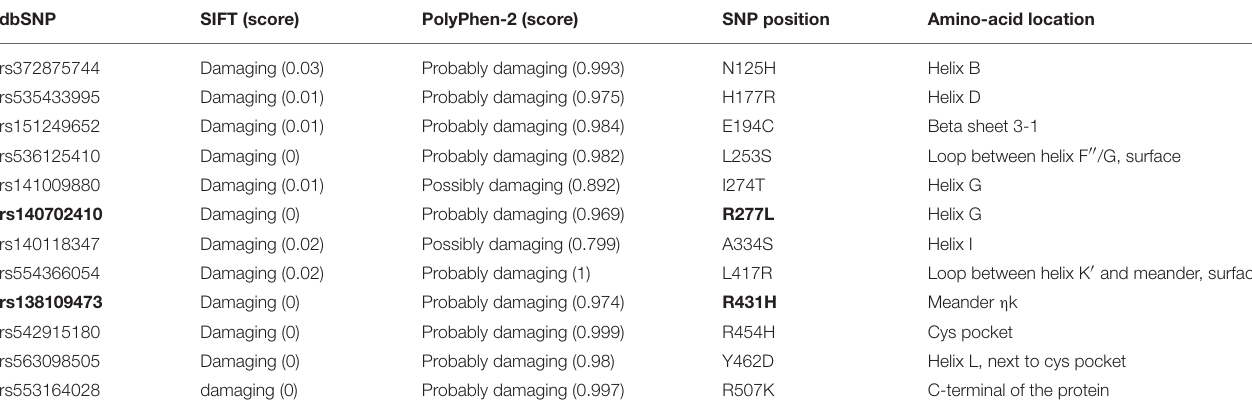
TABLE 3 | CYP51A1 SNPs predicted as deleterious or damaging by SIFT and PolyPhen-2 in regions not connected to enzymatic activity.